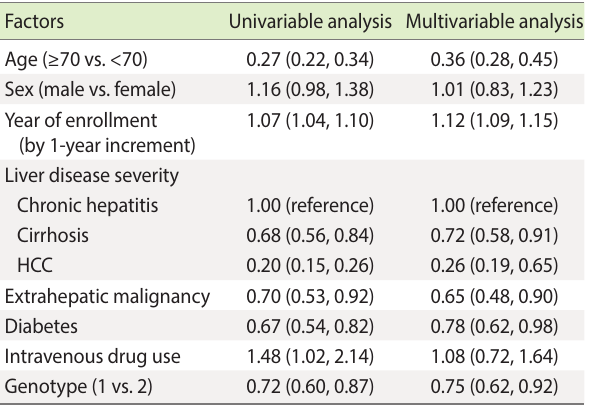
Table 5. Multivariable analysis for factors associated with treatment uptake Factors Univariable analysis Multivariable